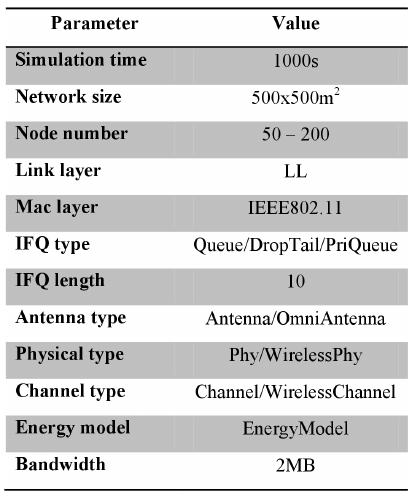
Table 2. Simulation Parameters.